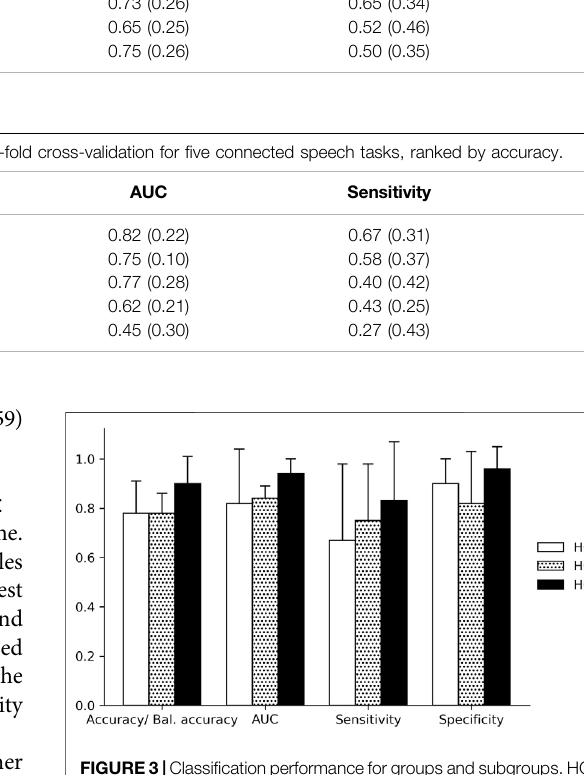
FIGURE3| Classi fi cationperformanceforgroupsandsubgroups.HC (cid:1) healthy control, MCI (cid:1) Mild Cognitive Impairment, AD (cid:1) Alzheimer ’ s disease, AD+MCI (cid:1) Alzheimer ’ s disease and Mild Cognitive Impairment group. All classi fi cations used linguistic features from the overlearned narrative recall task. Error bars + 1